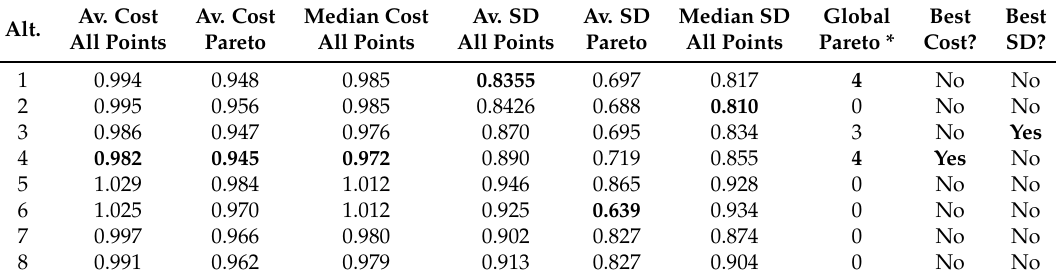
Table 2. Descriptors and assessment of each alternative. * Number of points/participation of each alternative in the global merged Pareto.